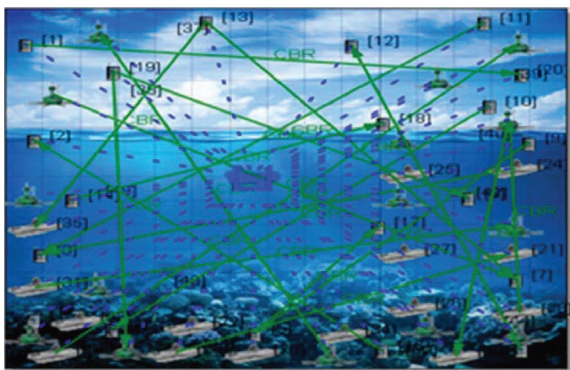
Figure 1: Typical underwater wireless communication structure.